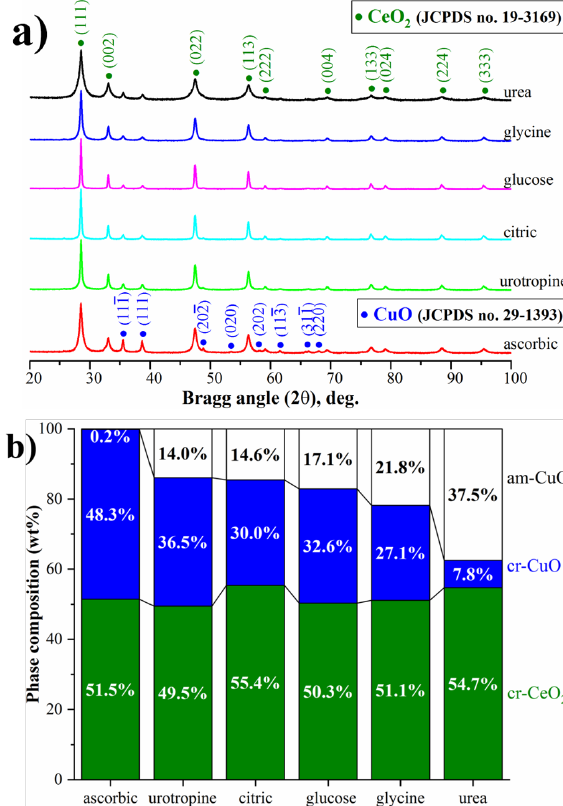
Figure 2: XRD patterns of the CuO/CeO 2 -ascorbic, -urotropine, - citric, -glucose, -glycine, -urea samples synthesized by the SCS method (a); phase composition of 6 catalysts obtained